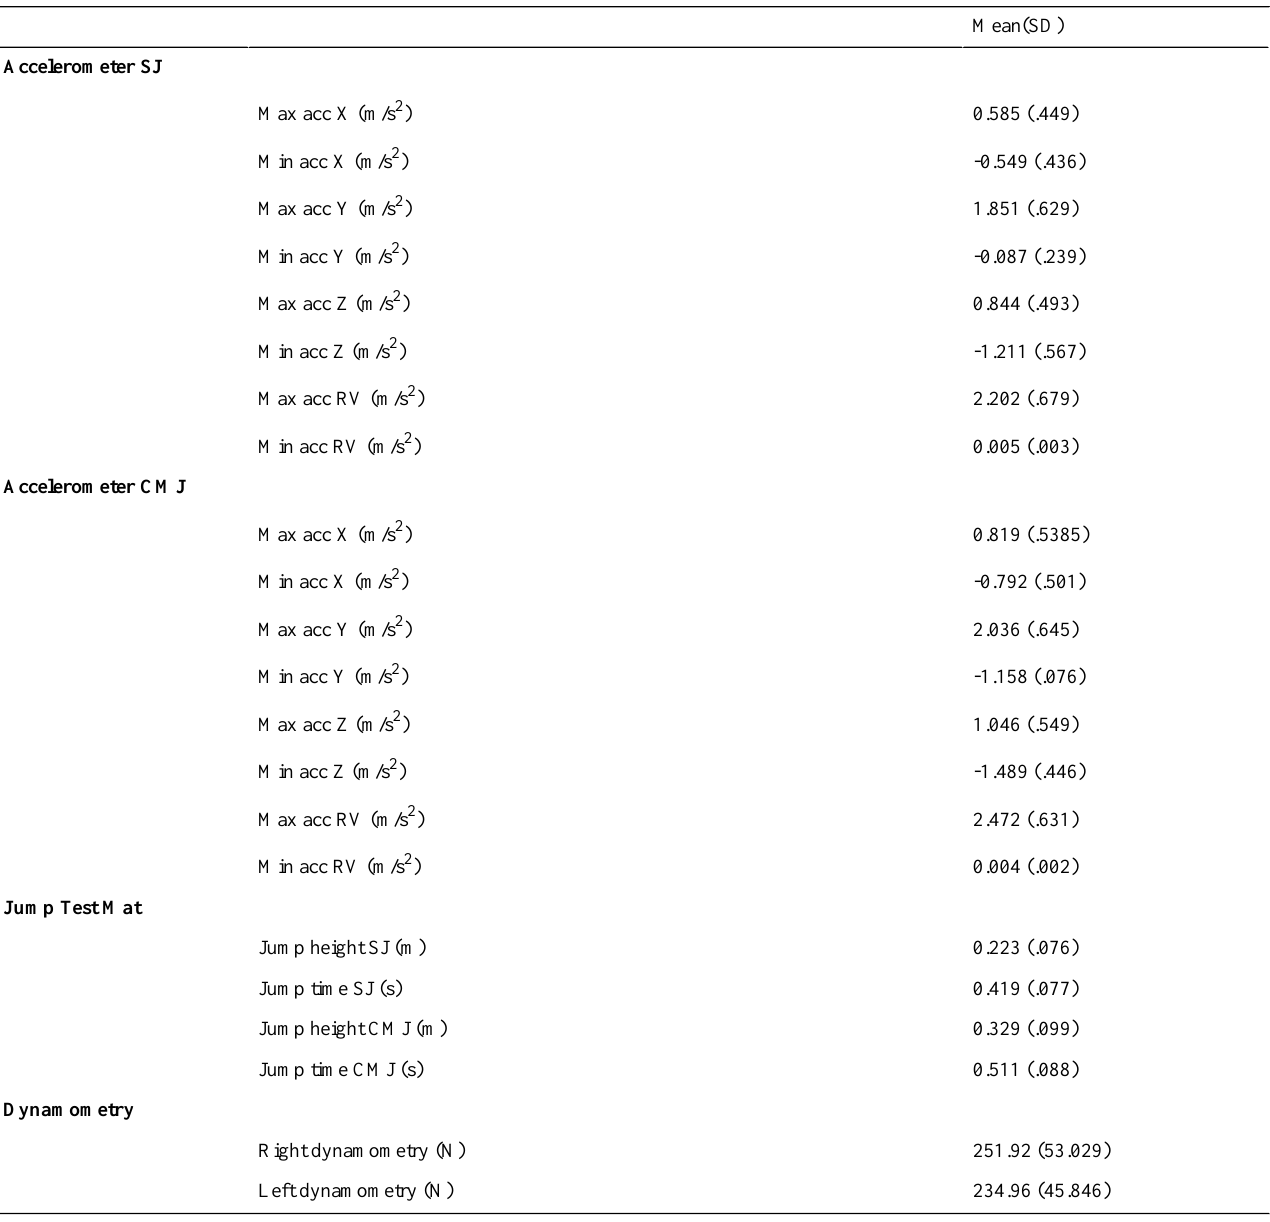
Table 2. Acceleration-based, jump test values and maximum isotonic strength in the SJ and CMJ (N=81